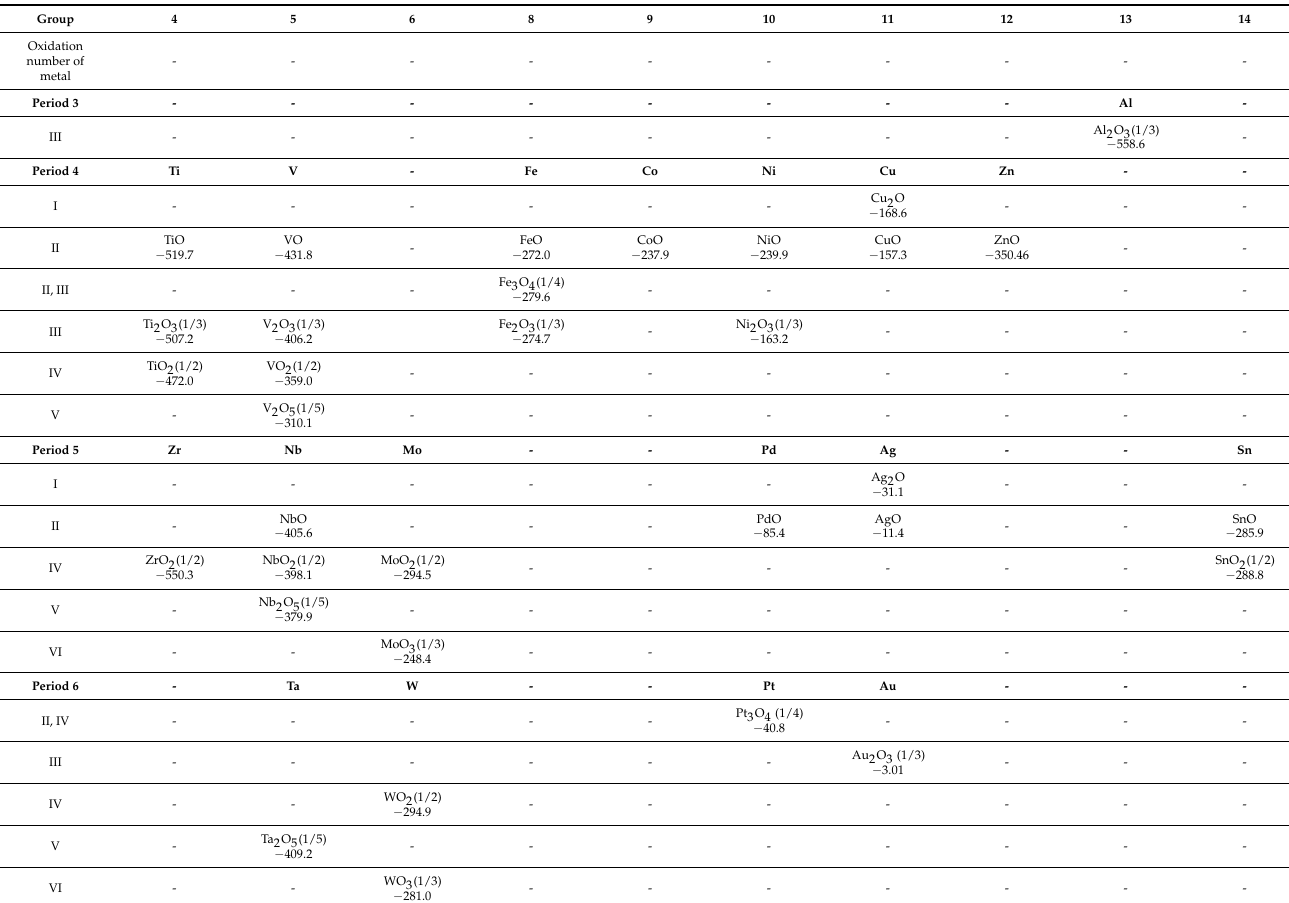
Table 2. The metal oxides with various oxidation numbers (Roman numerals) in the periods and groups of the periodic table and the values of ∆ f H 0 per oxygen atom of oxides ( ∆ f H 0 : the heat of formation at 298.15 K (unit: kJ mol − 1 ) 1 ).